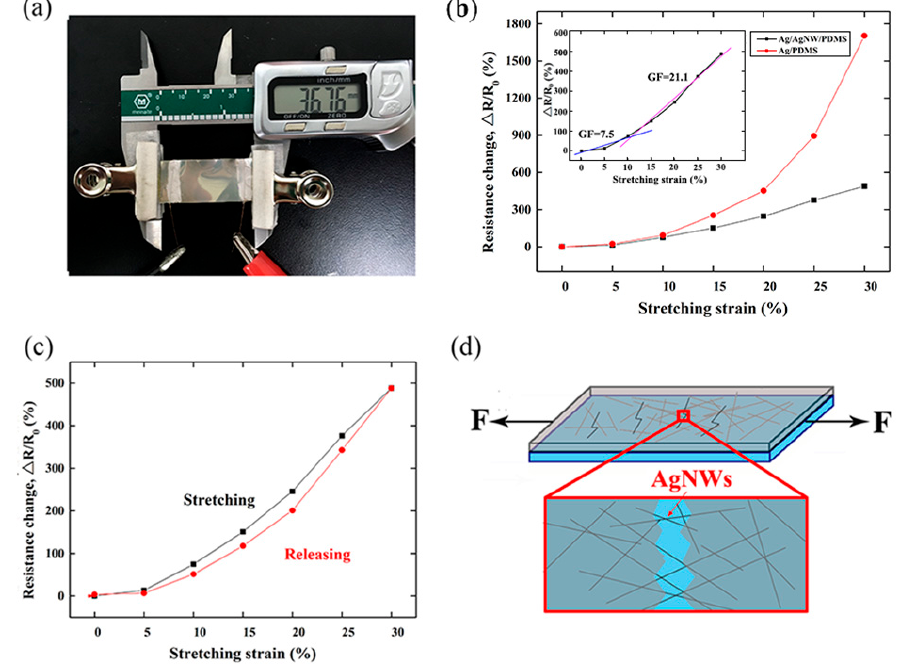
Figure 3. ( a ) Photograph of the experimental setup for measuring the relationship between ∆ R / R 0 and applied tensile strain. ( b ) ∆ R / R 0 profile of the Ag / PDMS sensor and Ag / NWs / PDMS strain sensor as a function of tensile strain. Inset shows the ∆ R / R 0 profile and associated GFs of the Ag / AgNWs / PDMS strain sensor in response to an applied tensile strain. ( c ) ∆ R / R 0 profile of the Ag / AgNWs / PDMS strain sensor under 1 stretch–release load cycle. ( d ) Schematic diagram of the conductivity principle of the Ag / AgNWs / PDMS strain